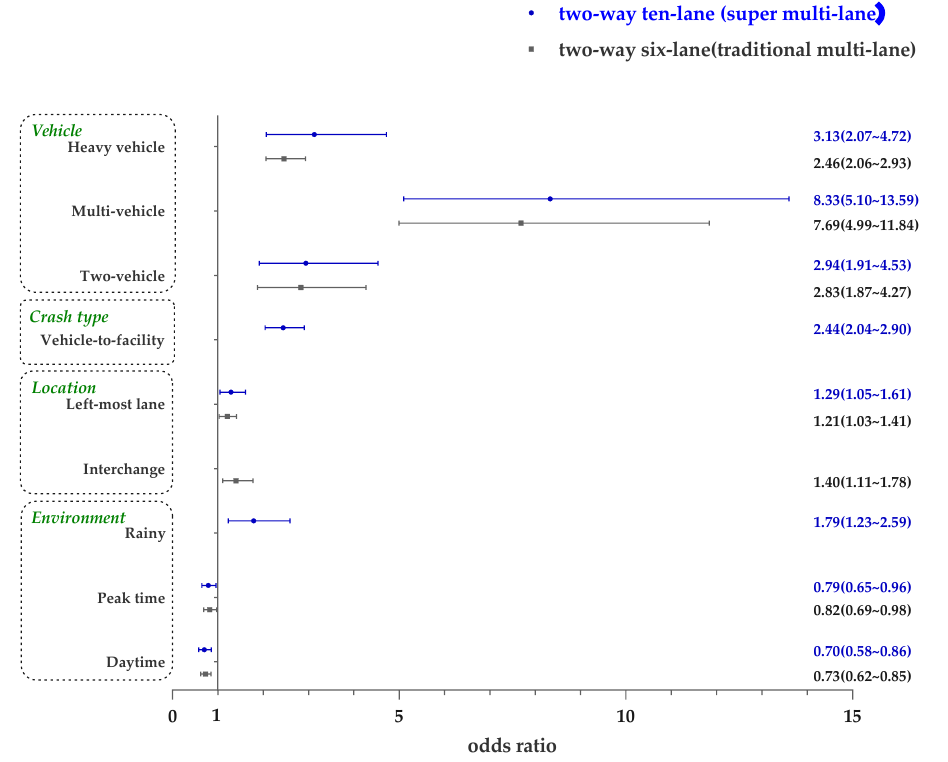
Figure 3. Odds Ratio of the influencing factors for crash severity on two-way ten-lane and six-lane